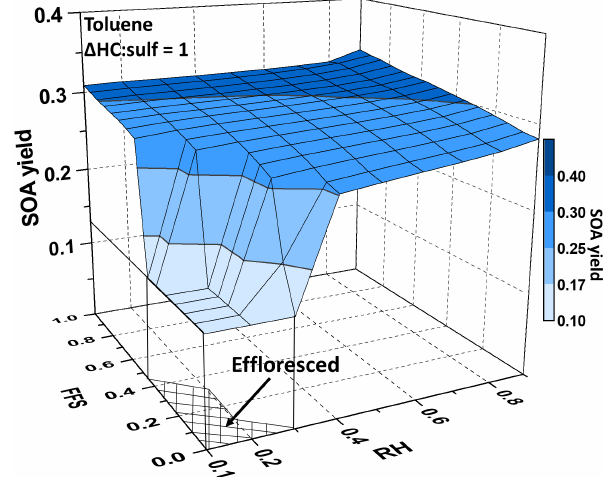
Figure 4. Simulated toluene SOA yields ( Y SOA = (cid:49) OM /(cid:49) HC at the end of the simulation, where (cid:49) OM is formed organic mat- ter and (cid:49) HC is consumed HC) as a function of relative humid- ity (RH: 0.1–0.9) and fractional free sulfate (FFS: 0–1), where FFS = ([SO 2 − ] − 0.5[NH + ])/[SO 2 − ], which is another numerical 4 4 4 indicator that is used to estimate aerosol acidity ([H + ]) in the inor- ganic thermodynamic model. The RH and FFS are fixed in the sim- ulations. The gas-phase simulations are based on the experimental condition of 14 June 2018 (Exp. Tol9 in Table 1) (initial HC con- centration = 5ppb, HC / NO x = 2, preexisting OM (OM 0 ) mass concentration = 2µgm − 3 , sulfate mass concentration = 20µgm − 3 , and the mass ratio of the consumed HC to sulfate ( (cid:49) HC:sulf) =